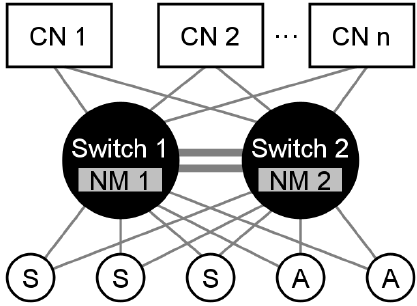
Figure 4. System